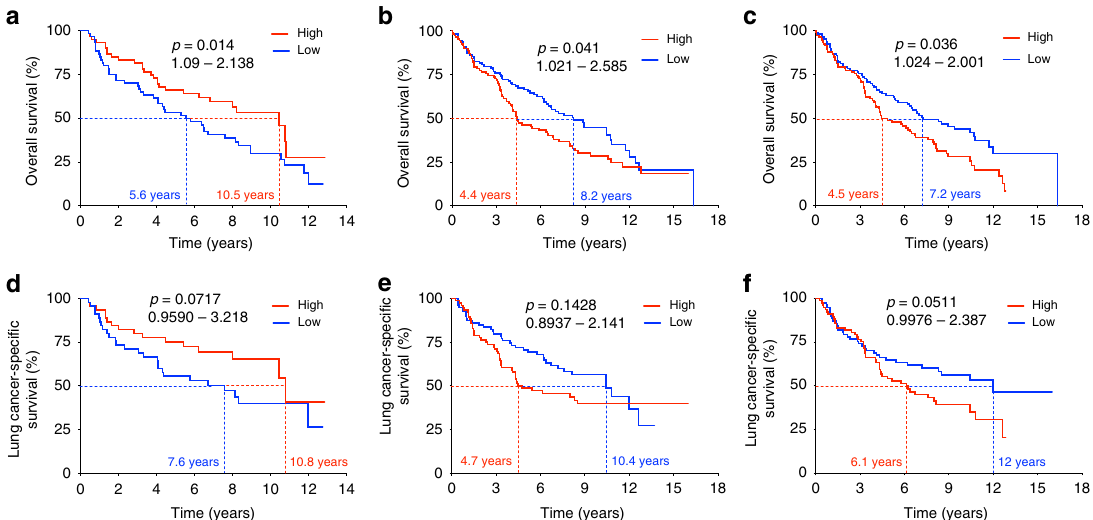
Fig. 9 A more tumor-focused lung T cell repertoire is associated with improved overall survival (OS). a Association between high (red) and low (blue) T cell density in PBMC and OS ( n = 120). b Association between high (red) and low (blue) T cell density in the uninvolved tumor-adjacent lung and OS ( n = 216). c Association between high (red) and low (blue) T cell clonality in the uninvolved tumor-adjacent lung (enriched compared to the tumor) and OS ( n = 214). d Association between high (red) and low (blue) T cell density in PBMC and lung cancer-speci fi c survival ( n = 90). e Association between high (red) and low (blue) T cell density in the uninvolved tumor-adjacent lung and lung cancer-speci fi c survival ( n = 157). f Association between high (red) and low (blue) T cell clonality in the uninvolved tumor-adjacent lung (enriched compared to the tumor) and lung cancer-speci fi c survival ( n = 156). High, above median; Low, below